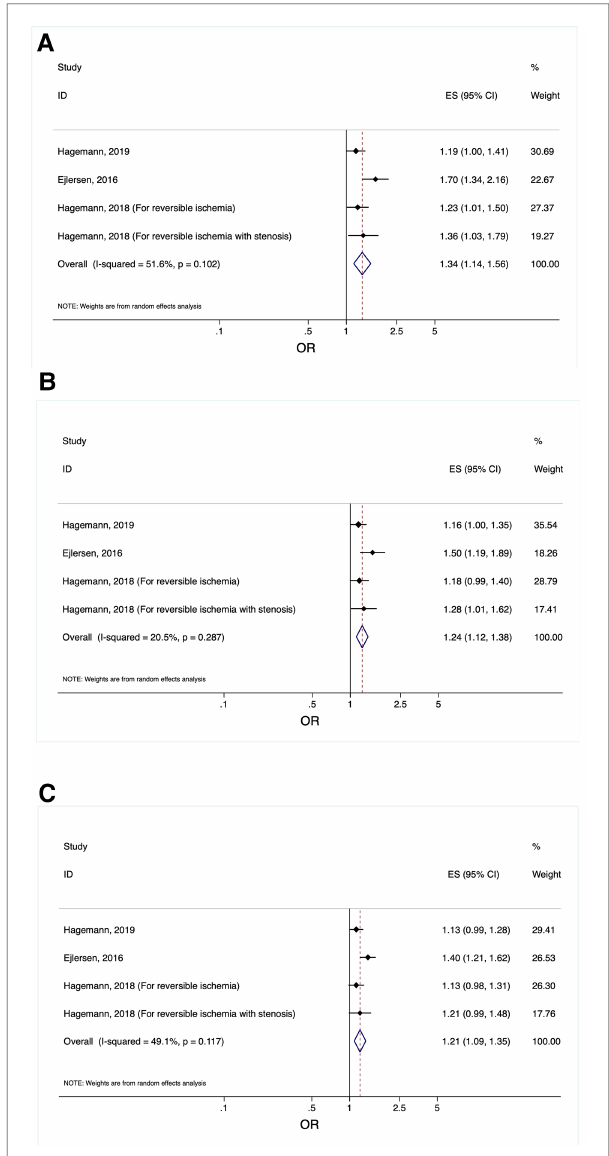
FIGURE 3 ( A ) Forest plot displaying the odds ratios obtained from multivariable logistic regression models in the included studies investigating the diagnostic value of epicardial longitudinal layer-speci fi c strain in patients suspected of SAP. Odds ratios from the studies investigating the diagnostic value of measuring epicardial longitudinal layer-speci fi c strain in patients suspected of SAP. Abbreviations: OR, odds ratio; CI, con fi dence interval. ( B ) Forest plot displaying the odds ratios obtained from multivariable logistic regression models in the included studies investigating the diagnostic value of mid-myocardial longitudinal layer-speci fi c strain in patients suspected of SAP. Odds ratios from the studies investigating the diagnostic value of measuring mid- myocardial longitudinal layer-speci fi c strain in patients suspected of SAP. Abbreviations: OR, odds ratio; CI, con fi dence interval. ( C ) forest plot displaying the odds ratios obtained from multivariable logistic regression models in the included studies investigating the diagnostic value of endocardial longitudinal layer-speci fi c strain in patients suspected of SAP. Odds ratios from the studies investigating the diagnostic value of measuring endocardial longitudinal layer-speci fi c strain in patients suspected of SAP. Abbreviations: OR, odds ratio; CI, con fi dence